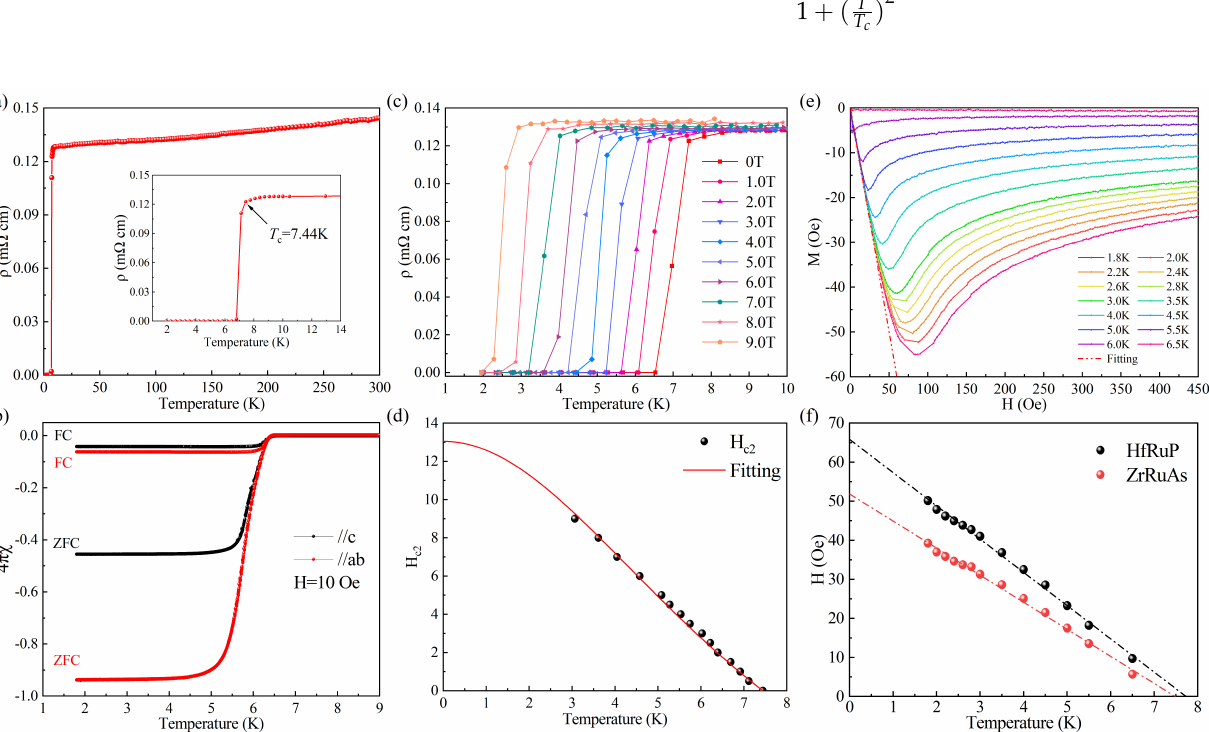
Figure 1. ( a ) Geometry and dimensions of the axisymmetric dumbbell specimens used in the fatigue Figure 2. Electrical resistivity of ZrRuAs without ( a ) and with ( c ) field. The inset of ( a ) is the electrical experiments; ( b ) geometry of the Cracked Round Bar (CRB) specimen; ( c ) Section A-A of the CRB resistivity of ZrRuAs lower than 14 K. ( b ) Temperature dependence of the magnetic susceptibility of specimen with the circumferential notch. ZrRuAs, measured in an applied field of 10 Oe using both the ZFC and FC protocols. ( d ) The upper critical field H c 2 versus the transition temperature T c for ZrRuAs. The solid red line represents a fit to the G-L formula. ( e ) The field-dependent magnetization was recorded at various temperatures of ZrRuAs. For each temperature, H c 1 was determined as the value where M ( H ) starts deviating from linearity (see red dashed line). ( f ) The lower critical field H c1 versus the transition temperature T c for HfRuP and ZrRuAs. The dashed line represents a linear